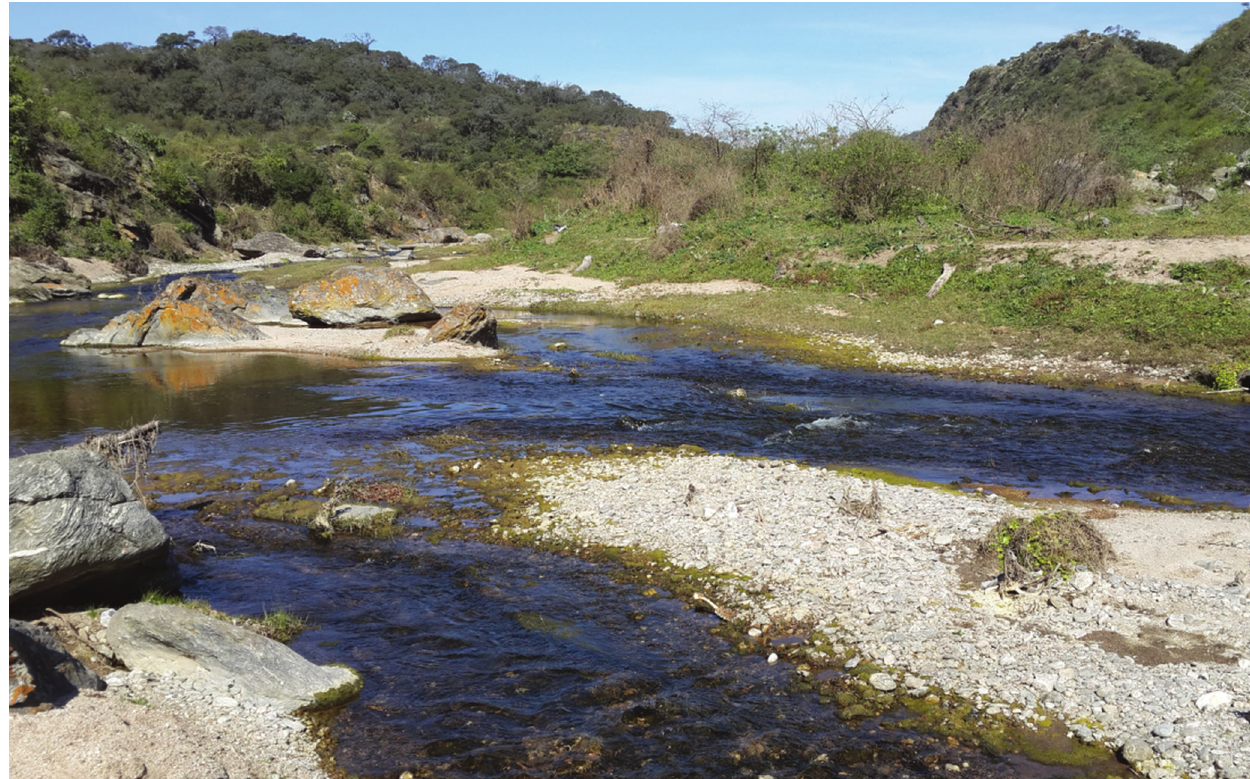
Fig. 3. Headwaters of Río Sucuma , type locality of Astyanax powelli , Catamarca province,